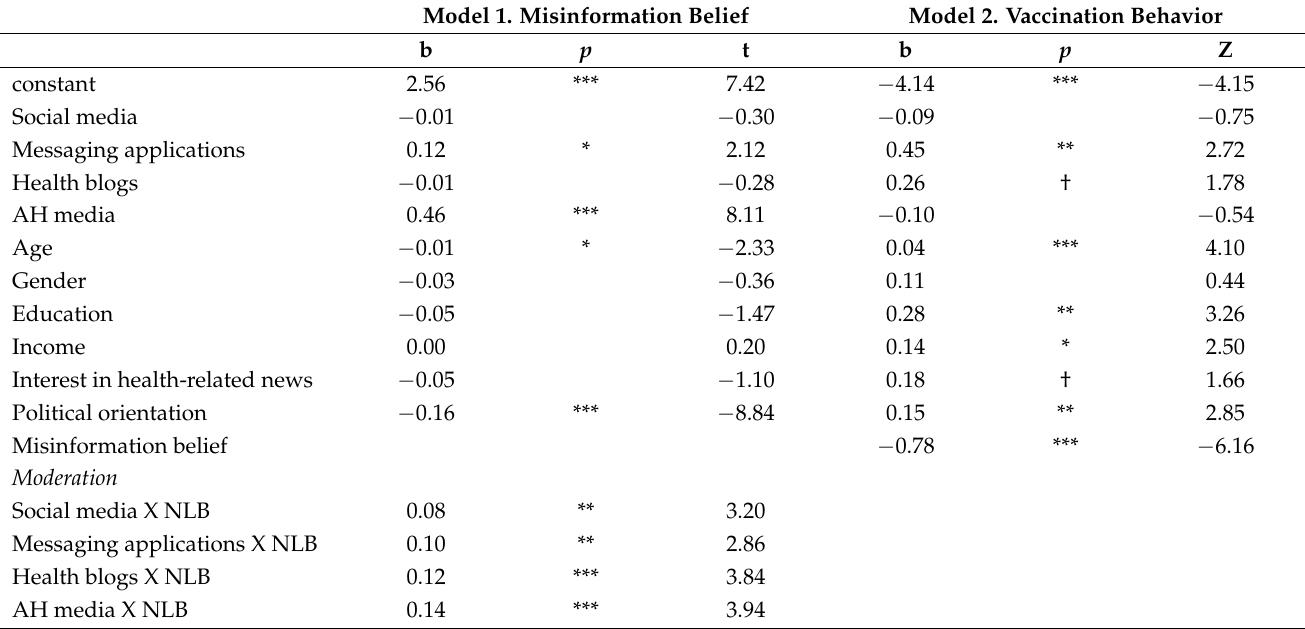
Table A1. Regression models of the main direct effects (US subset: N = 550).